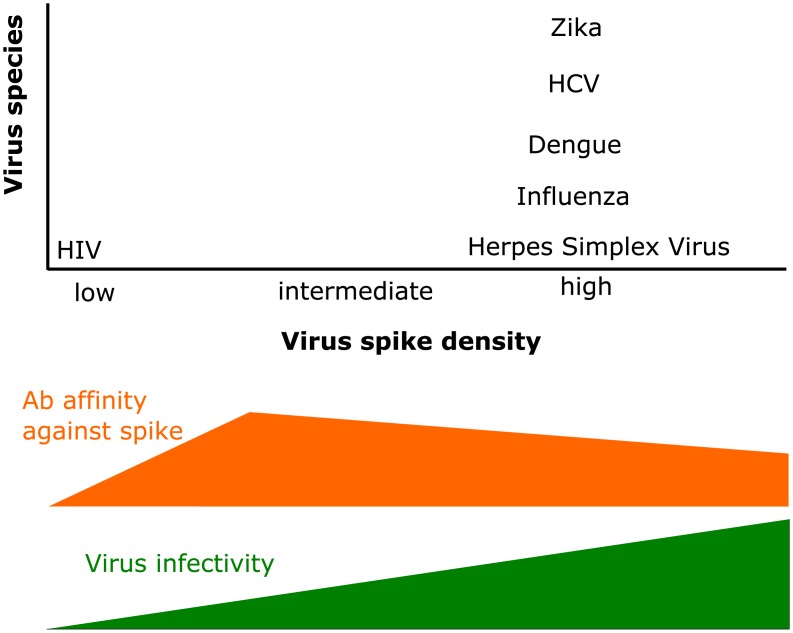
The immune pressure on a virus may determine its spike density.The distribution of viruses species according to their spike density (see Table 1). We illustrate the immune pressure created by Ab affinity (orange), which is non-monotonous with density. The infectivity of a virus increases with its spike density (green).